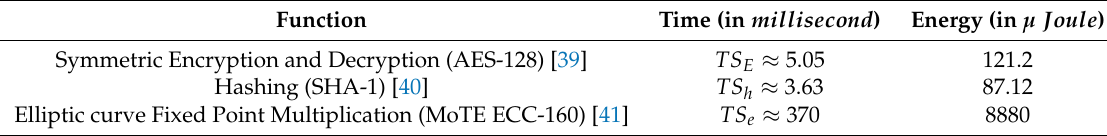
Table 26. Execution time and energy consumption on MicaZ sensor node for cryptographic operations.